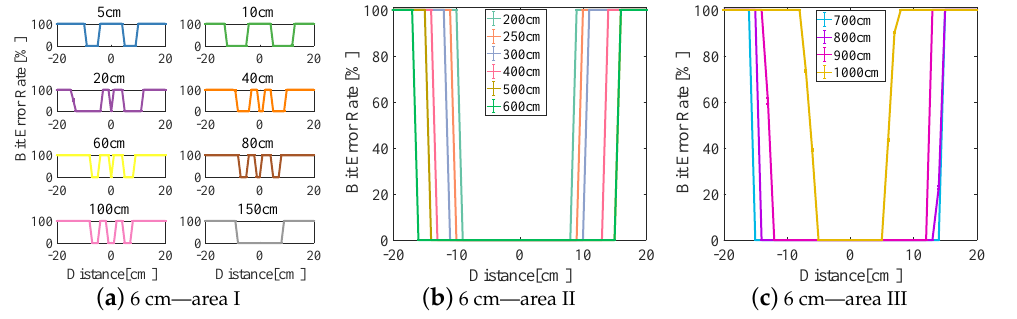
Figure 10. Lampshade height: 6